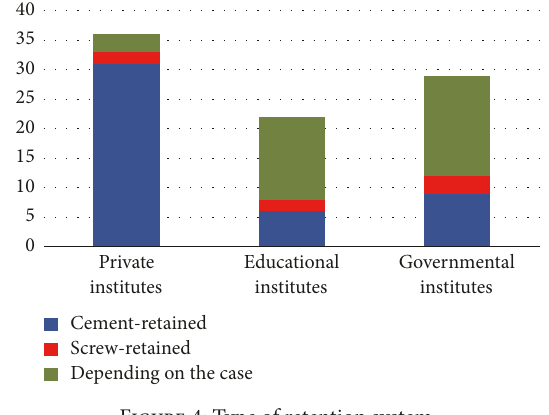
Figure 7: Failure of dental implants with an association with a retention